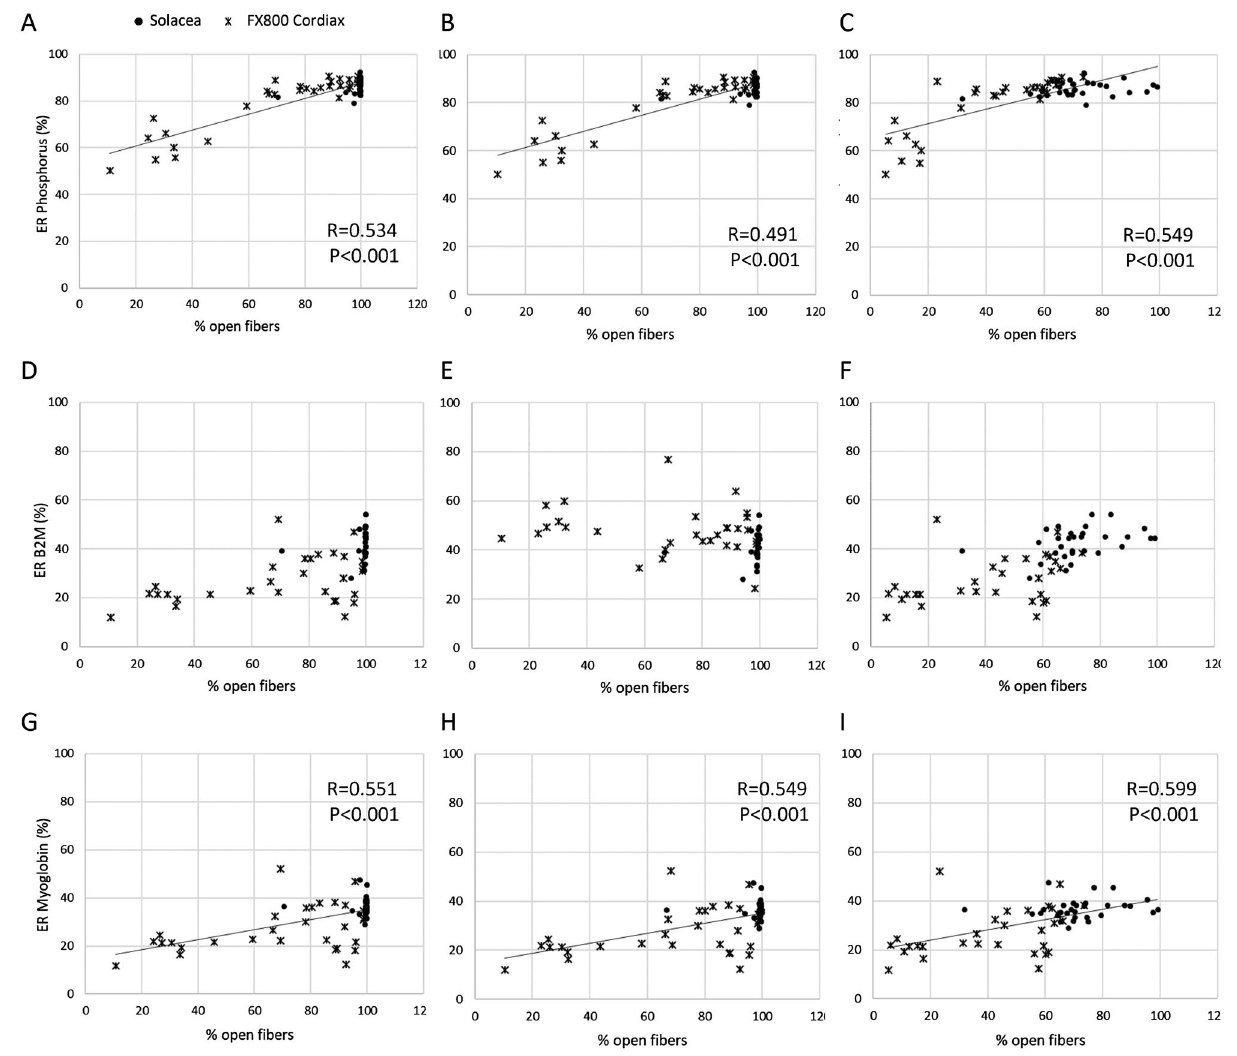
Figure 3. Relations between ER and % open fibers at the end of dialysis with the Solacea (dots) and the FX800 CorDiax (crosses) for phosphorus (panels A – C ), B2M (panels D – F ), and Myoglobin (panels G – I ) for different % of open fiber area: 50% (panels A , D , G ), 70% (Panels B , E , H ), and 90% (panels C , F , I